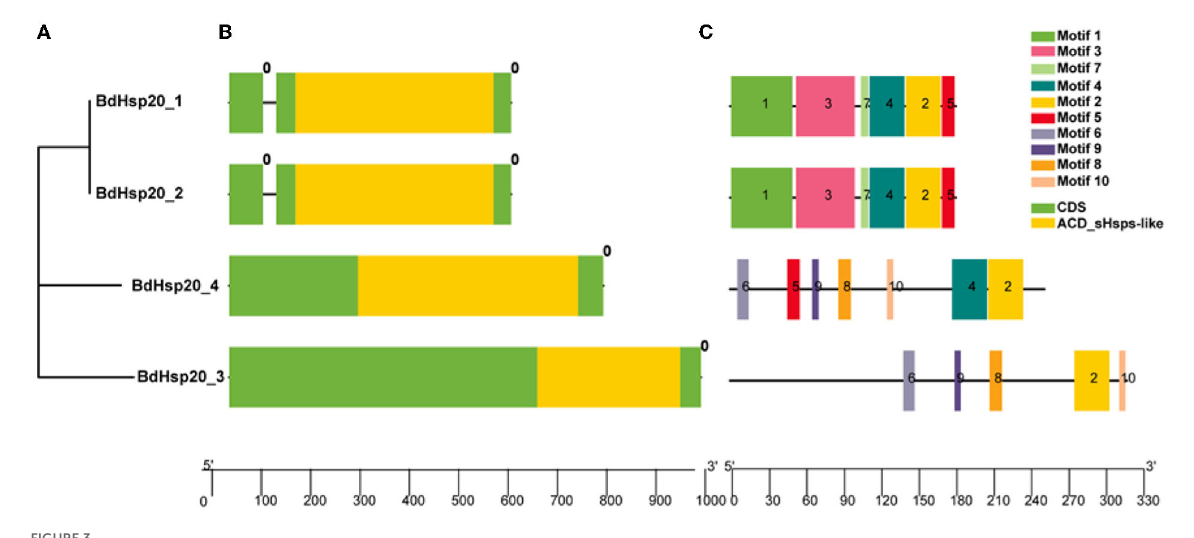
FIGURE3 Phylogenetic relationships (A) , conserved domains, gene structures (B) and motifs (C) of the BdHsp20 gene family.